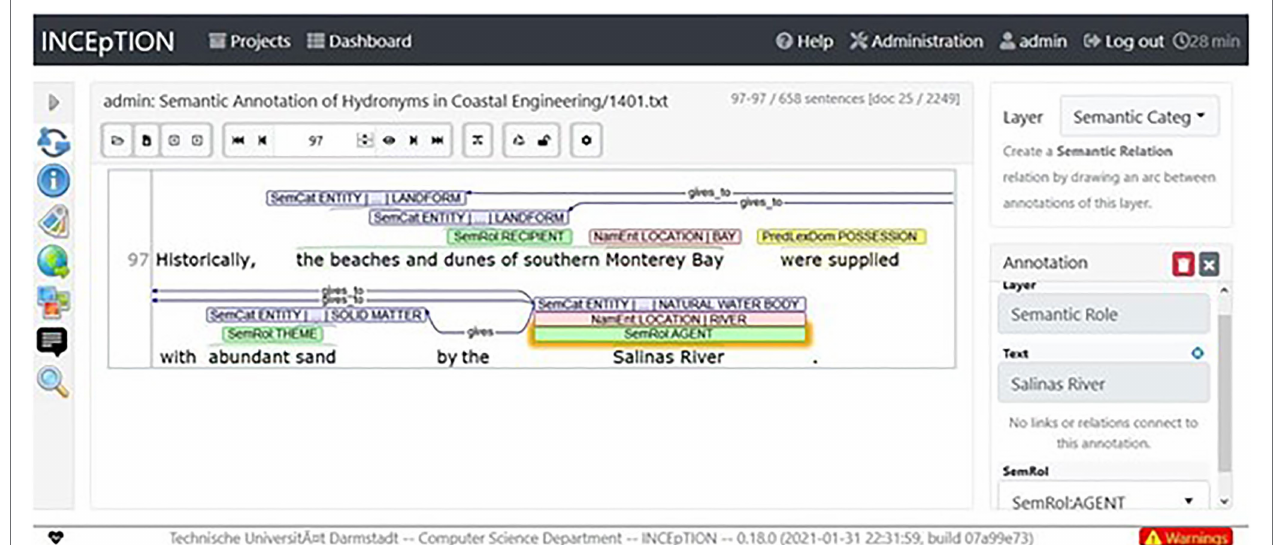
FIGURE 1 | Annotation user interface of the INCEpTION tool, where the semantic annotation of the predicate-argument structure of sentences mentioning a named river in the Coastal Engineering corpus was carried out. In the example sentence, the Salinas River and the Monterey Bay are mentioned. Image reproduced with the permission of Dr. Richard Eckart de Castilho, INCEpTION project lead at the The Ubiquitous Knowledge Processing (UKP) Lab at the Department of Computer Science, Technische Universität